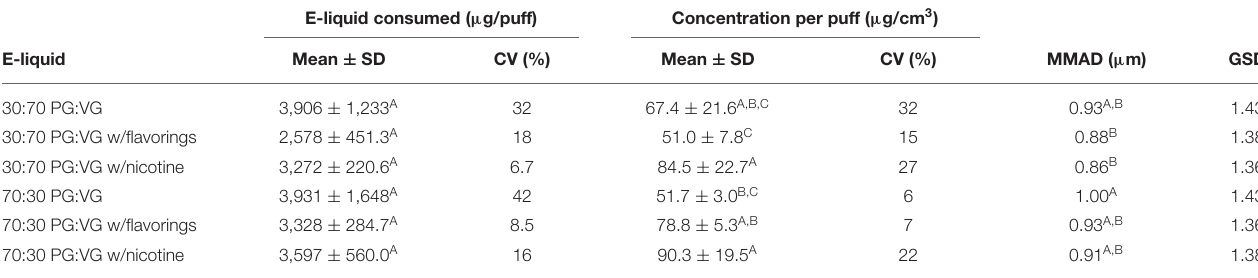
TABLE 1 | Influence of e-liquid formulation on mass-based aerosol characteristics measured using a low-flow cascade impactor ( n = 6 trials/e-liquid). E-liquid consumed ( µ g/puff) Concentration per puff ( µ g/cm 3 )